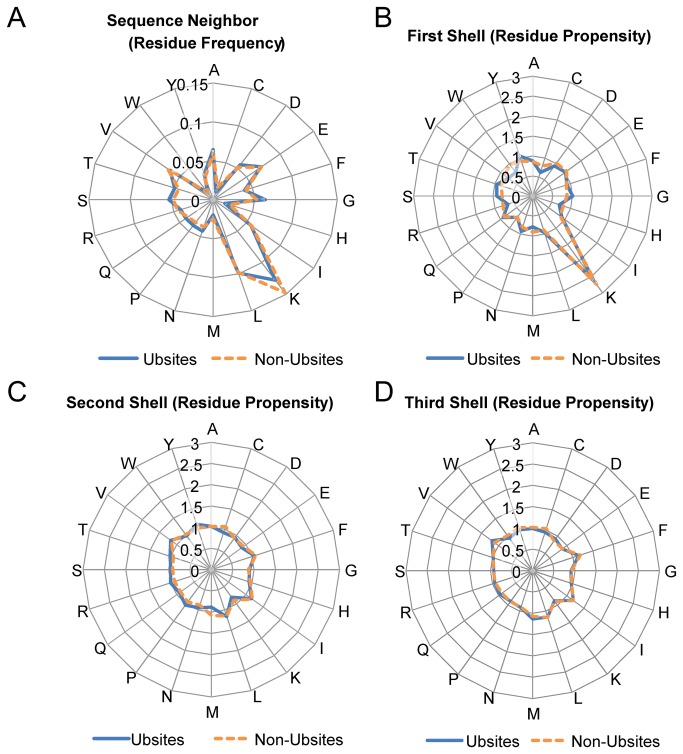
The residue usage in the proximal context and the microenvironments.(A-D) The radar diagrams which illustrate (A) the average residue frequencies in the proximal context (sequence neighbors within the ±6 residue range around the central lysine); (B) the average residue propensities in the first shell (Cβ distance, 0Å~7.5 Å proximal to the central lysine); (C) the average residue propensities in the second shell (Cβ distance, 7.5Å~11.5 Å); (D) the average residue propensities in the third shell (Cβ distance, 11.5Å~15.5 Å).